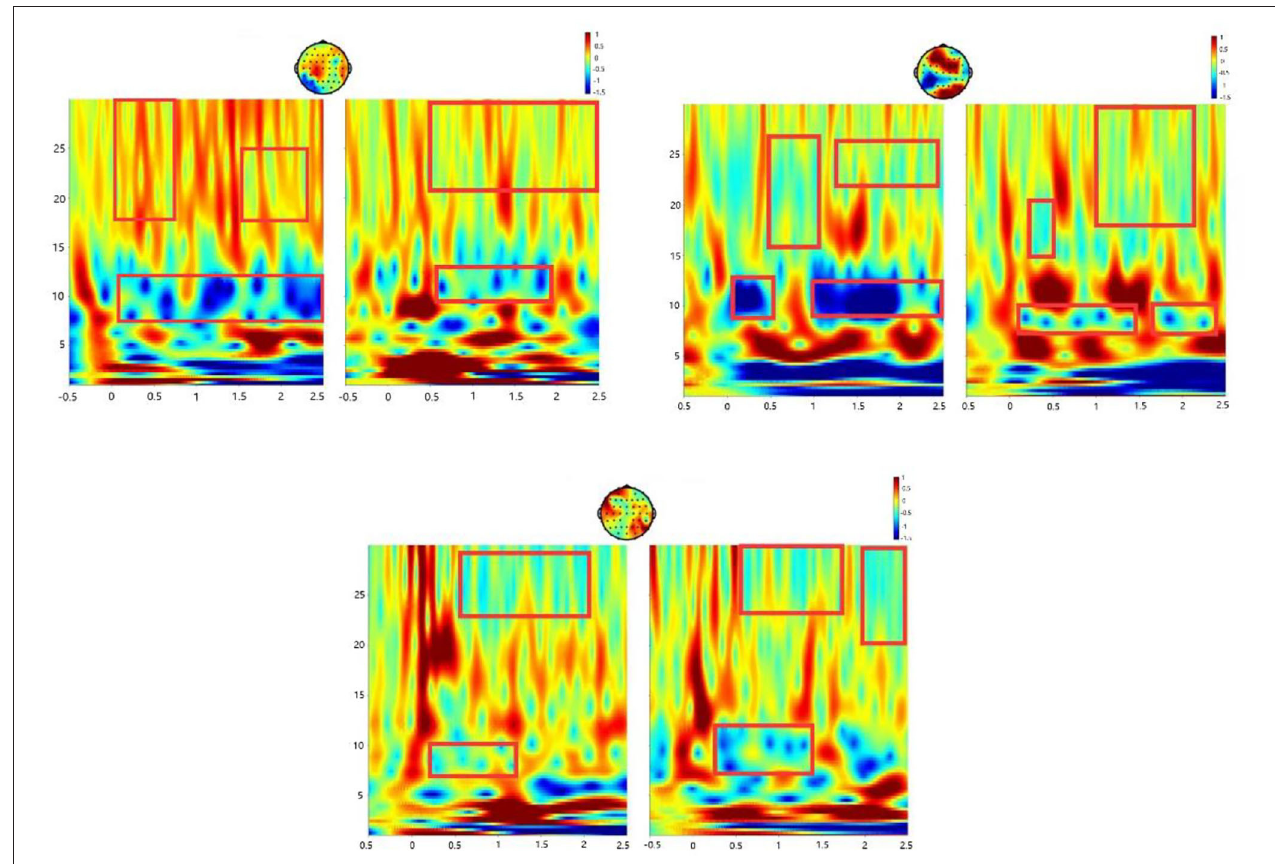
FIGURE 4 | ERD/ERS time–frequency analysis of three groups in S1.